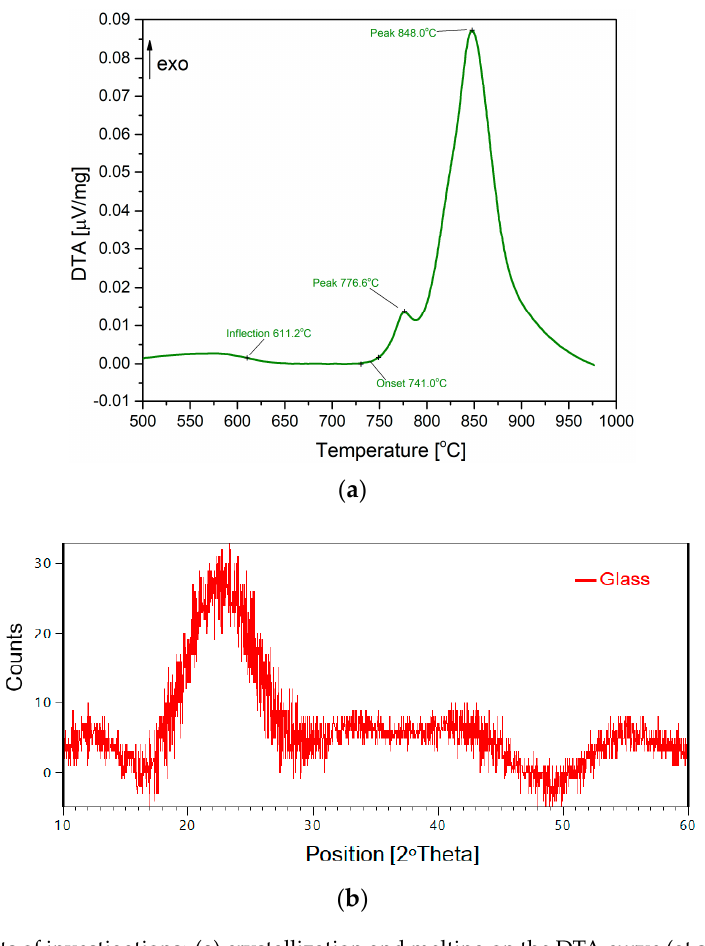
Figure 2. Results of investigations: ( a ) crystallization and melting on the DTA curve (at step 10 °C/min); and ( b ) X-ray diffraction pattern of 93GeO 2 –6Al 2 O 3 –1Bi 2 O 3 glass (T = 20 °C). Crystals 2020 , 10 , x